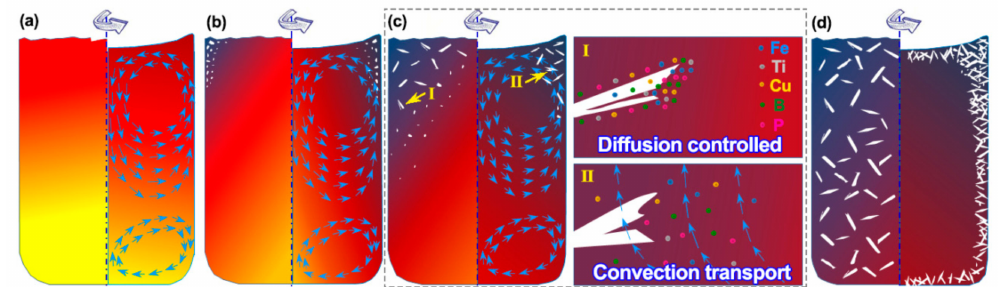
Figure 9. Schematic illustration of segregation behavior of impurities in the growth process of primary Si without (left side) and with RMF (right side): ( a ) the temperature gradient was formed by controlling the heat dissipation of the graphite crucible, ( b ) the temperature gradient established a low temperature nucleation zone, ( c ) the primary Si which is the pre-nucleation grew continuously absorbing Si atoms from the remaining liquid metal, ( d ) the ending of the primary Si